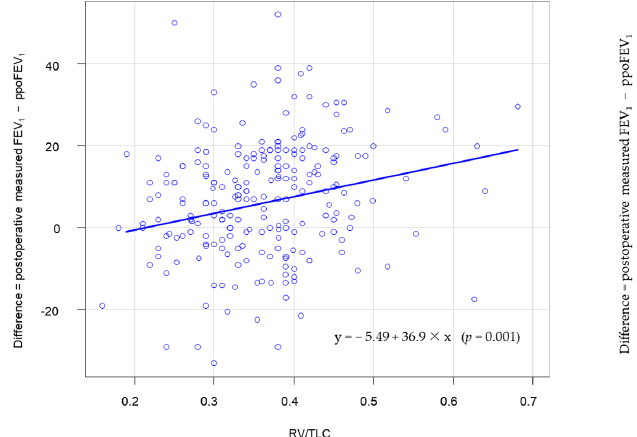
Table 4. Correlation of differences (postoperative FEV 1 minus ppoFEV 1 ) with preoperative PFT parameters and postoper- ative FEV 1 .